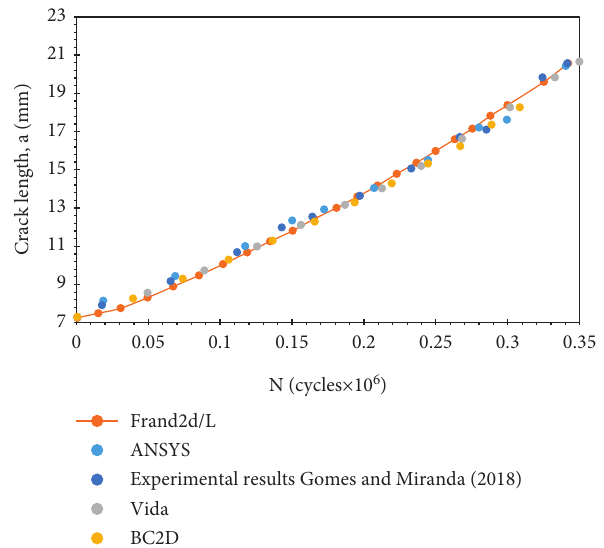
Figure 17: Comparison of the fatigue life and cracks length for the CTS01